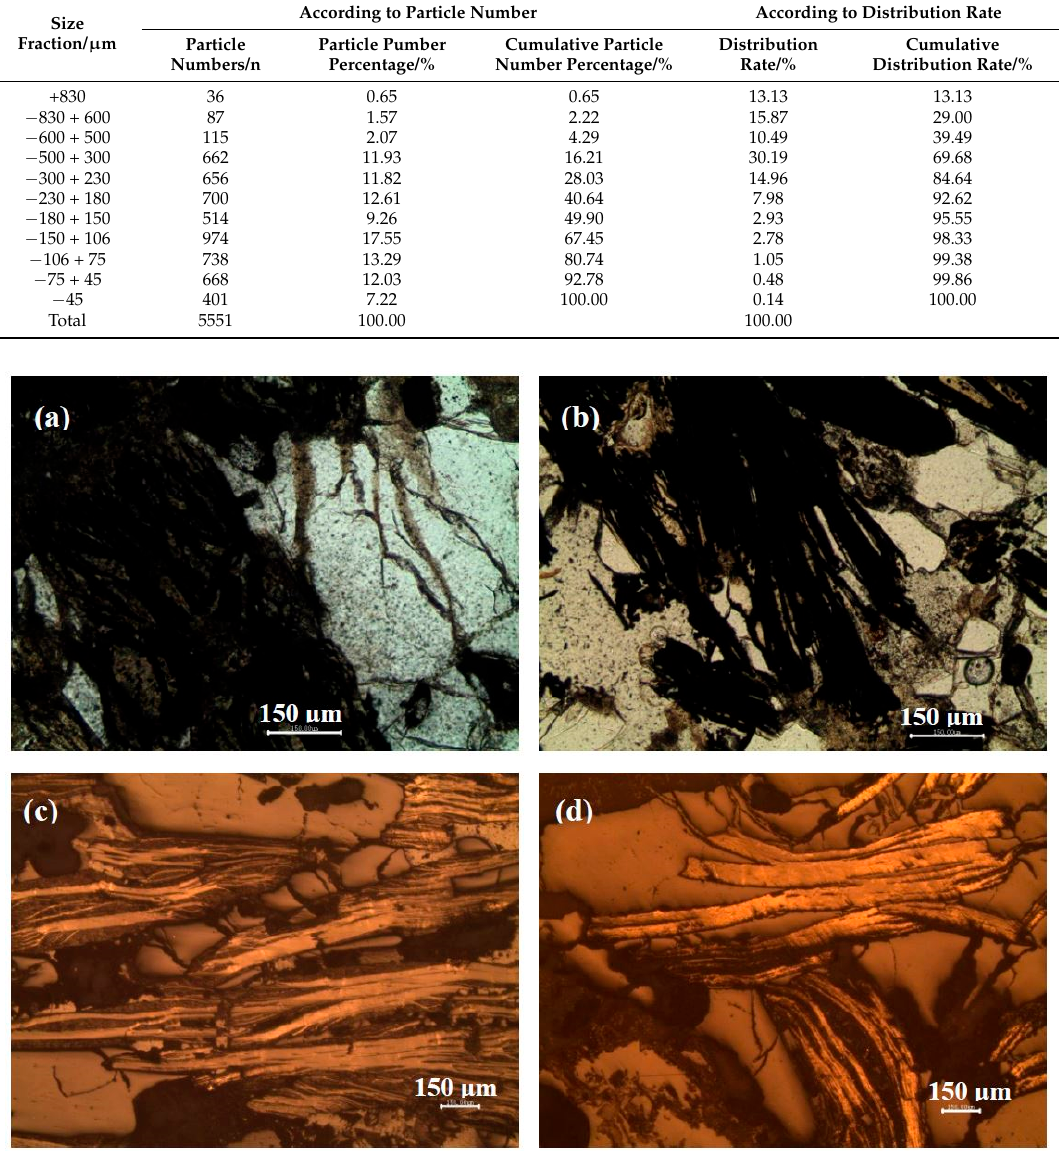
Figure 2. Optical microscope images of the raw ore: ( a , b ) polarizing microscope images 100×; ( c , d ) reflecting microscope images 50×.